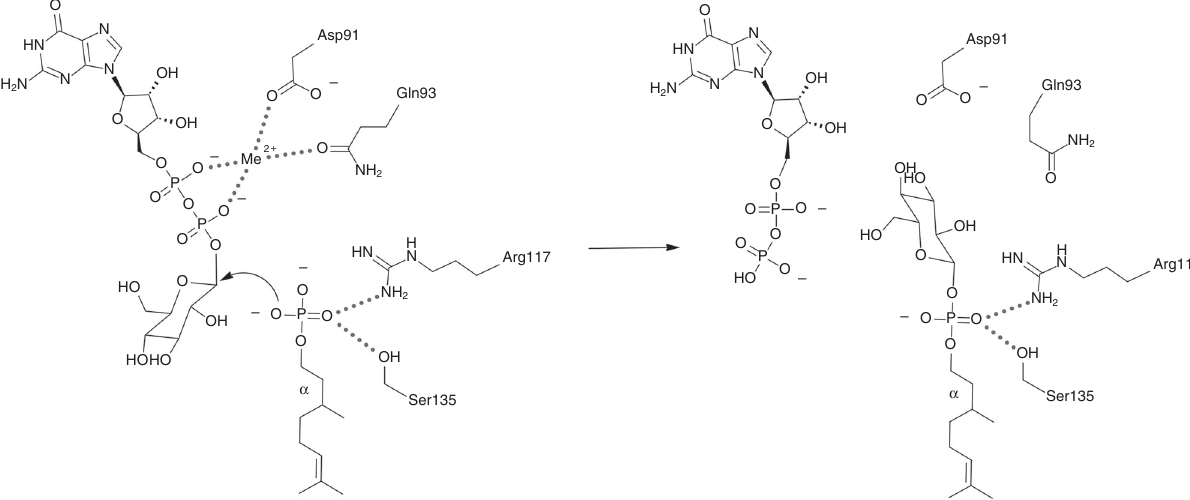
Fig. 4 Catalytic mechanism of Pf DPMS. Catalytic mechanism of the transfer reaction. Nucleophilic attack by the Dol- P phosphate oxygen on the mannosyl C1 carbon yields GDP and Dol- P -Man. Asp91 and Gln93 coordinate the GDP-Man diphosphate groups via the metal ion, while the key side chains for positioning the Dol- P phosphate group for mannosyl transfer are Ser135 and Arg117